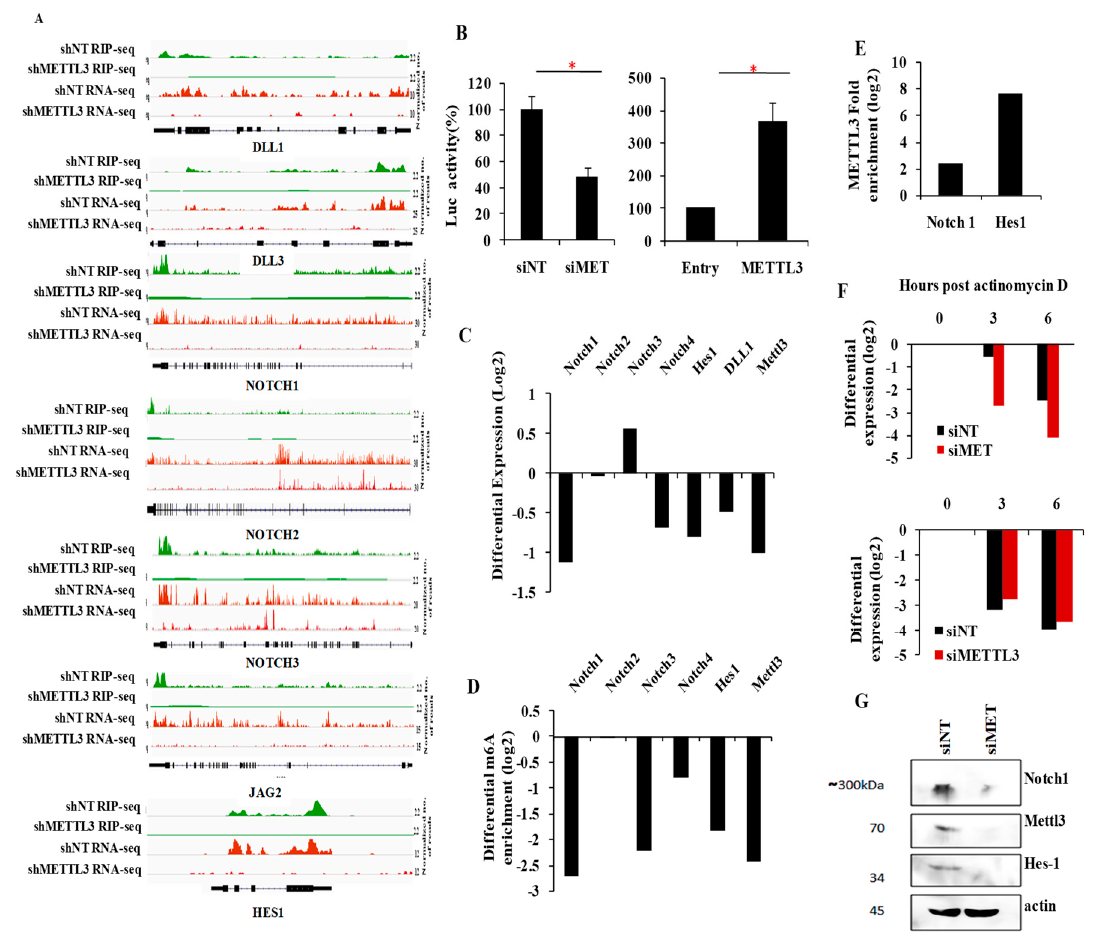
Figure 6. METTL3-dependent m 6 A modification positively regulates NOTCH signaling. ( A ) The genomic tracks for Notch pathway genes–DLL1, DLL3, NOTCH1, NOTCH2, NOTCH3, JAG2 and HES1 are depicted in both shNT vs. shMETTL3 m 6 A RIP-Seq and RNA-Seq. Normalized sequence coverage of m 6 A RIP peaks and RNA-Seq reads is indicated above the gene architecture in UCSC format. Thin black boxes represent the 5 (cid:48) and 3 (cid:48) UTRs and thick black boxes represent the coding sequences and thin lines represent introns. ( B ) HES-1 promoter luciferase activity was measured after silencing (left panel) and over expression of METTL3 (right panel). Luciferase activity was plotted as percentage after normalization to the control cells. Silencing of METTL3 reduced NOTCH activation while over-expression induced the NOTCH pathway. ( C ) Transcript levels of NOTCH pathway members, which have multiple METTL3-dependent m 6 A RIP-Seq peaks, were measured post-METTL3silencing. Differential expression was measured compared to siNT condition by real-time qPCR and plotted as log 2 ratio. ( D ) Differential m 6 A enrichment of NOTCH 1, NOTCH 2, NOTCH 3, NOTCH 4 and HES1 genes were measured by m 6 A RIP-PCR after METTL3-silencing and were plotted as log 2 ratio. The enrichment was normalized to siNT condition, ( E ) Enrichment of NOTCH1 and HES1 genes were measured by METTL3 RIP-PCR and were plotted as log 2 . Anti-METTL3 immunoprecipitation (IP) was normalized to IgG control IP. ( F ) NOTCH1 (top) and HES1 (bottom) transcripts were measured at indicated time points post actinomycin D (5 µ g/mL) treatment in siNT and siMETTL3 condition by reverse transcription-qPCR. The log 2 ratio of remaining NOTCH1 was plotted using linear regression after normalizing to the 0th hour of respective condition. ( G ) Protein levels of full-length NOTCH1 and Hes1 after METTL3 knockdown. The p -value was analyzed by Student’s t -test. *** p -value <0.001, ** p -value <0.01, * p -value <0.05. Error bars represent standard